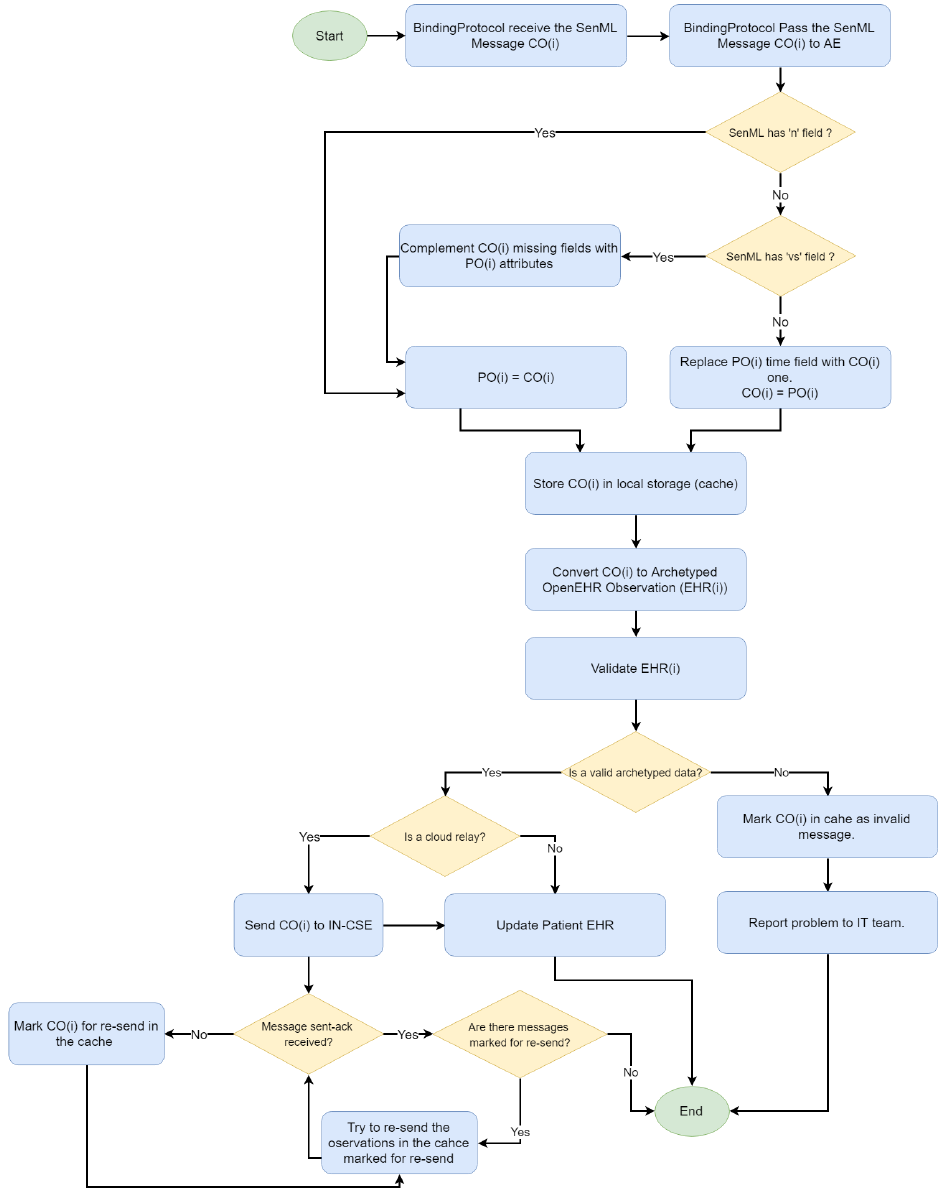
Figure 11. Message handling (Fog